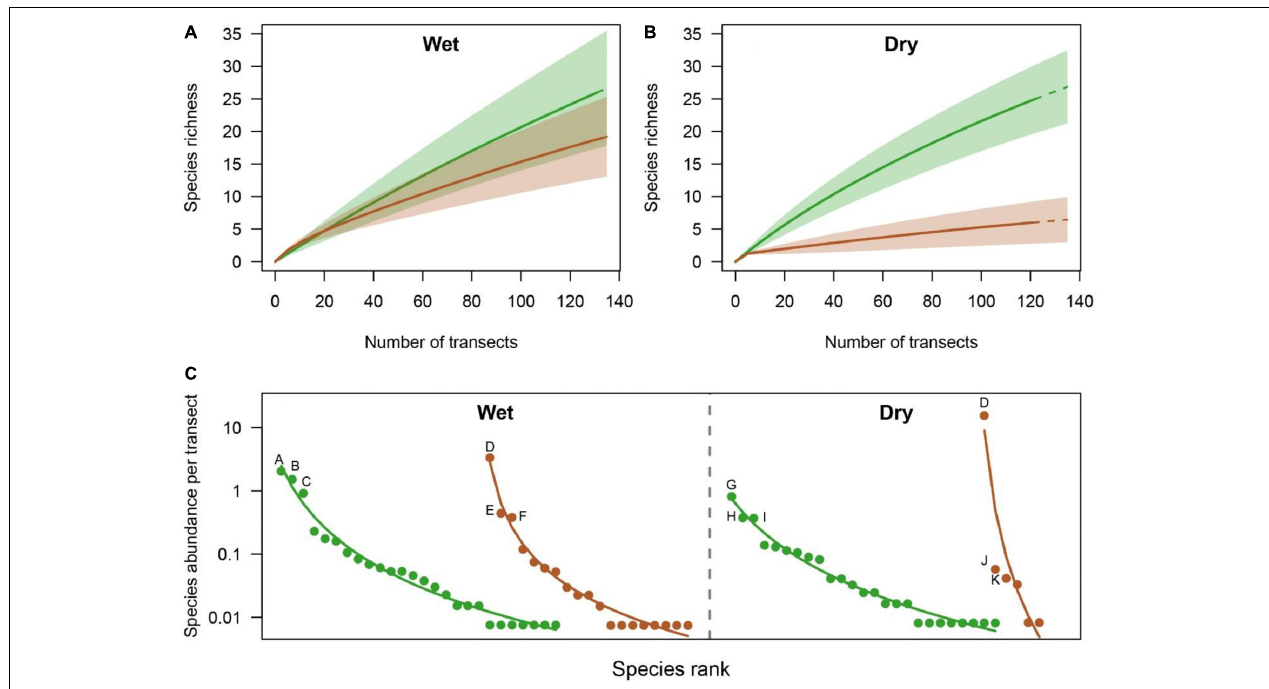
FIGURE 3 | Sample-based species accumulation curves (A,B) and rank-abundance plots (C) for fruits found on transect walks by site (green = Ivindo; brown = Wonga Wongué) and season. In (A,B) : lines denote the mean species richness for each site and shaded areas represent 95% confidence intervals. In (C) : points = species specific abundances; lines = fitted values from a mandlebrot model of species abundances; letters = the three most abundant fruit species in each site by season (A = Ivindo msp16; B = Tetrapleura tetraptera ; C = Nauclea diderrichii ; D = Sacoglottis gabonensis ; E = Pachypodanthium staudtii ; F = Uapaca guineensis G = Dacryodes buettneri ; H = Irvingia robur ; I = Ivindo msp2; J = Wonga Wongué msp2; K = Batunga spp.).